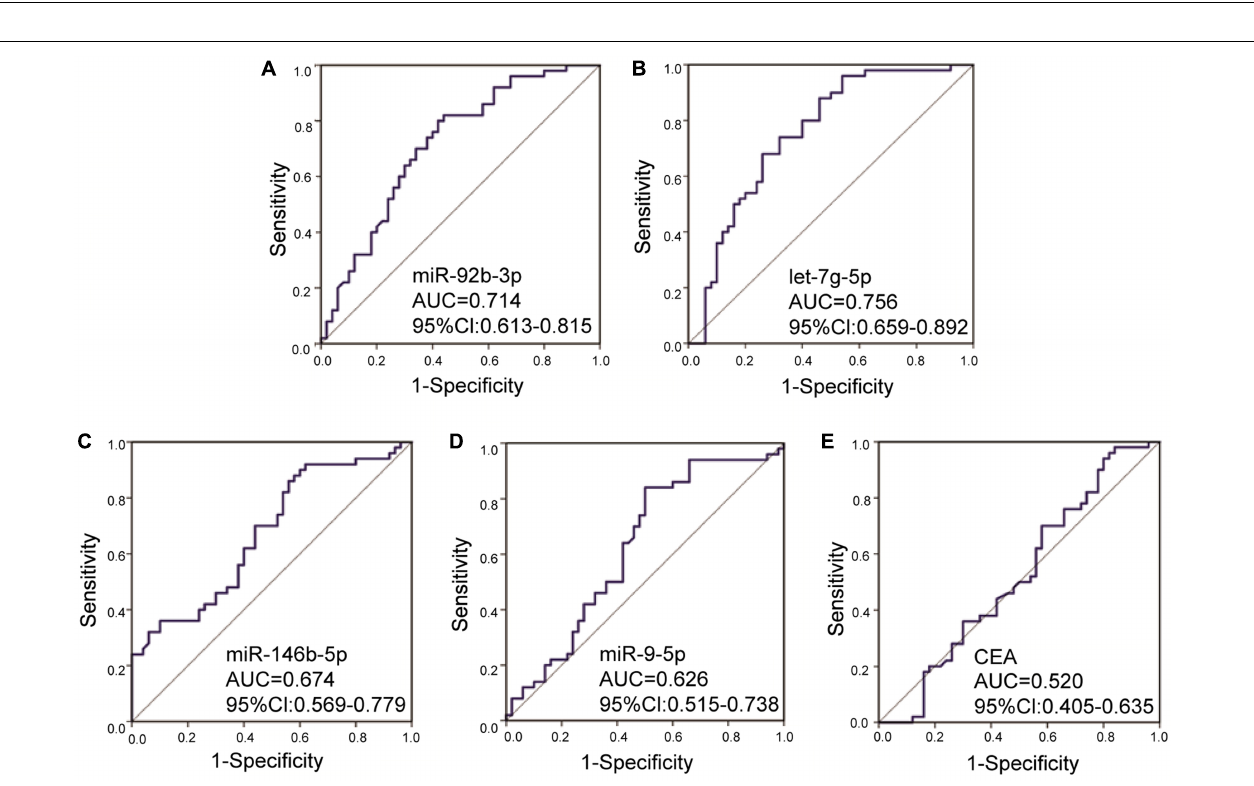
FIGURE 3 | Receiver operating characteristic curves for the serum exosomal miRNAs and CEA to discriminate early-stage gastric cancer patients from healthy individuals. The AUC values of miR-92b-3p (A) , let-7g-5p (B), miR-146b-5p (C) , miR-9-5p (D) , and CEA (E) were 0.714 ( p = 0.0002), 0.756 ( p < 0.0001), 0.674 ( p = 0.0028), 0.626 ( p = 0.0299), and 0.520 ( p = 0.7329), respectively. AUC, area under the receiver operating characteristic curve; CI, confidence interval.